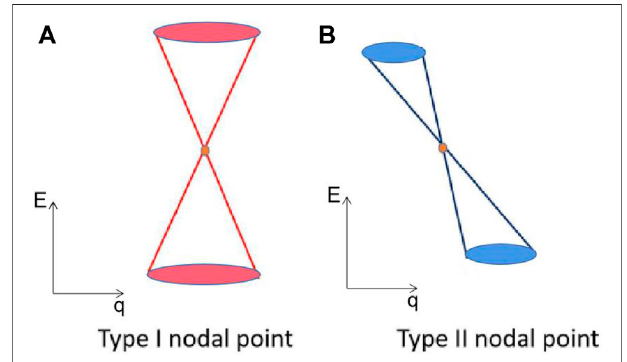
FIGURE 1 | Illustration of the type (A) I and (B) II